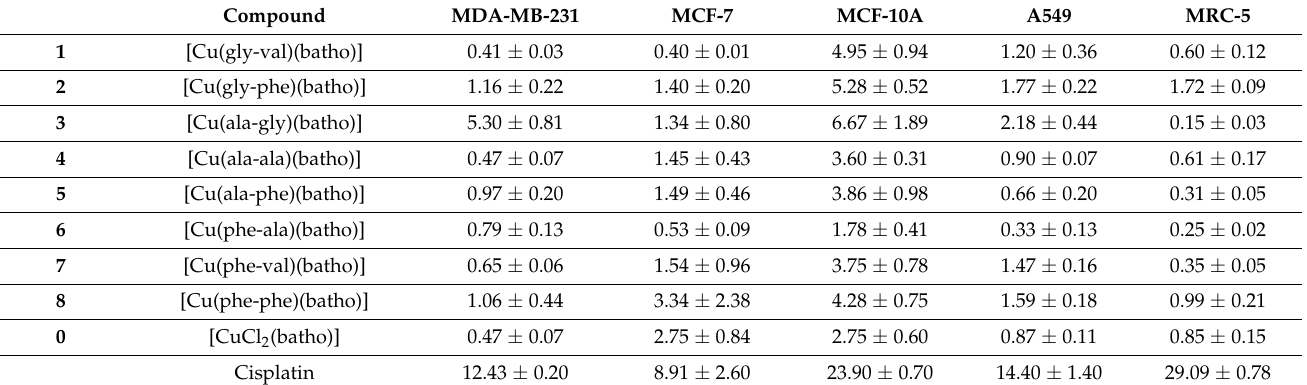
Table 4. Cytotoxic activity (expressed by IC 50 in µ M) of the studied complexes after 48 h of incubation, against MCF-7, MDA-MB-231 (human breast adenocarcinomas, the latter triple negative), MCF-10A (breast non-tumor), A549 (human lung epithelial carcinoma), and MRC-5 (lung non-tumor).